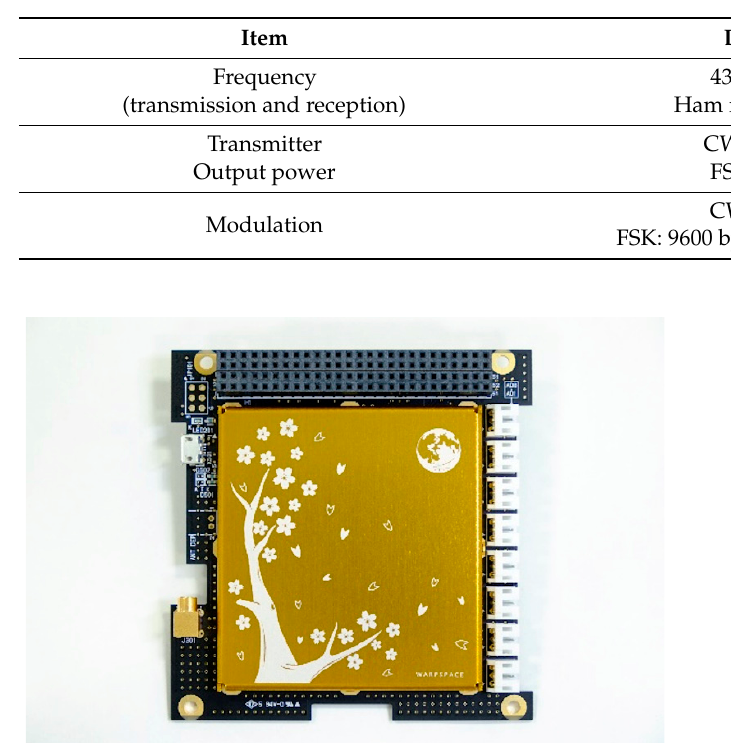
Figure 13. Block diagram of the transceiver for the satellite. Table 10. Satellite communication equipment specifications.